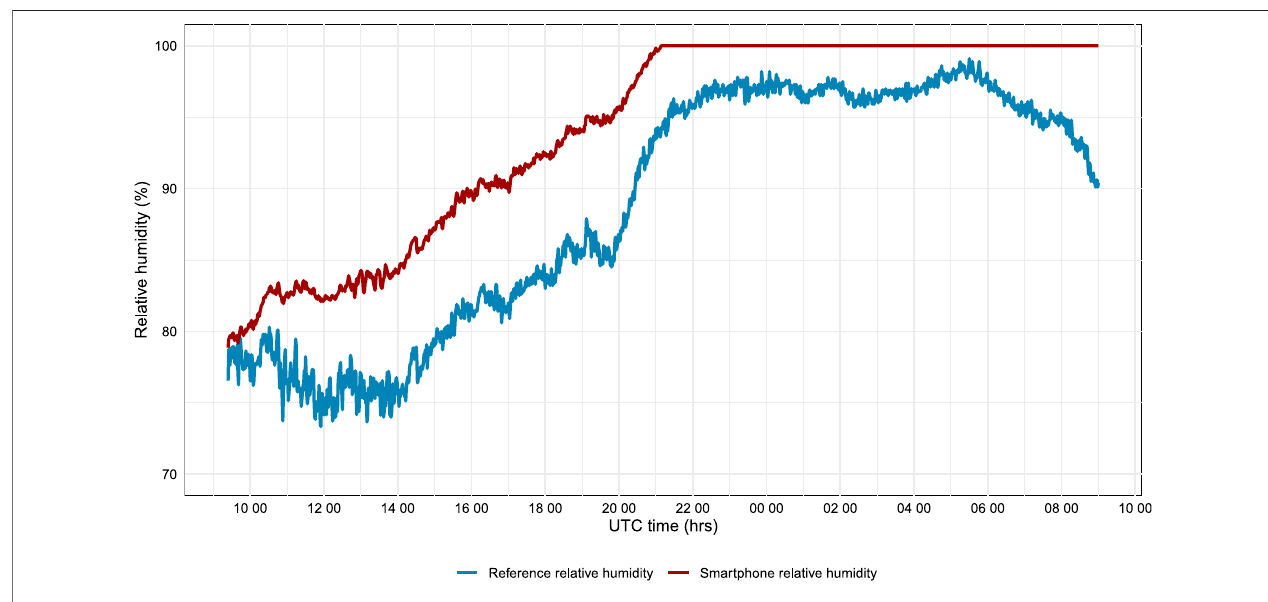
FIGURE8| ObservedRHbythesmartphonesensor(redline)andthereferenceobservations(blueline)fora24 hperiodattheVeenkampenweatherstation.Inthis experiment, the smartphone was located inside the Stevenson screen for January 27 th 2018 10:00 UTC — January 28 th 2018 10:00